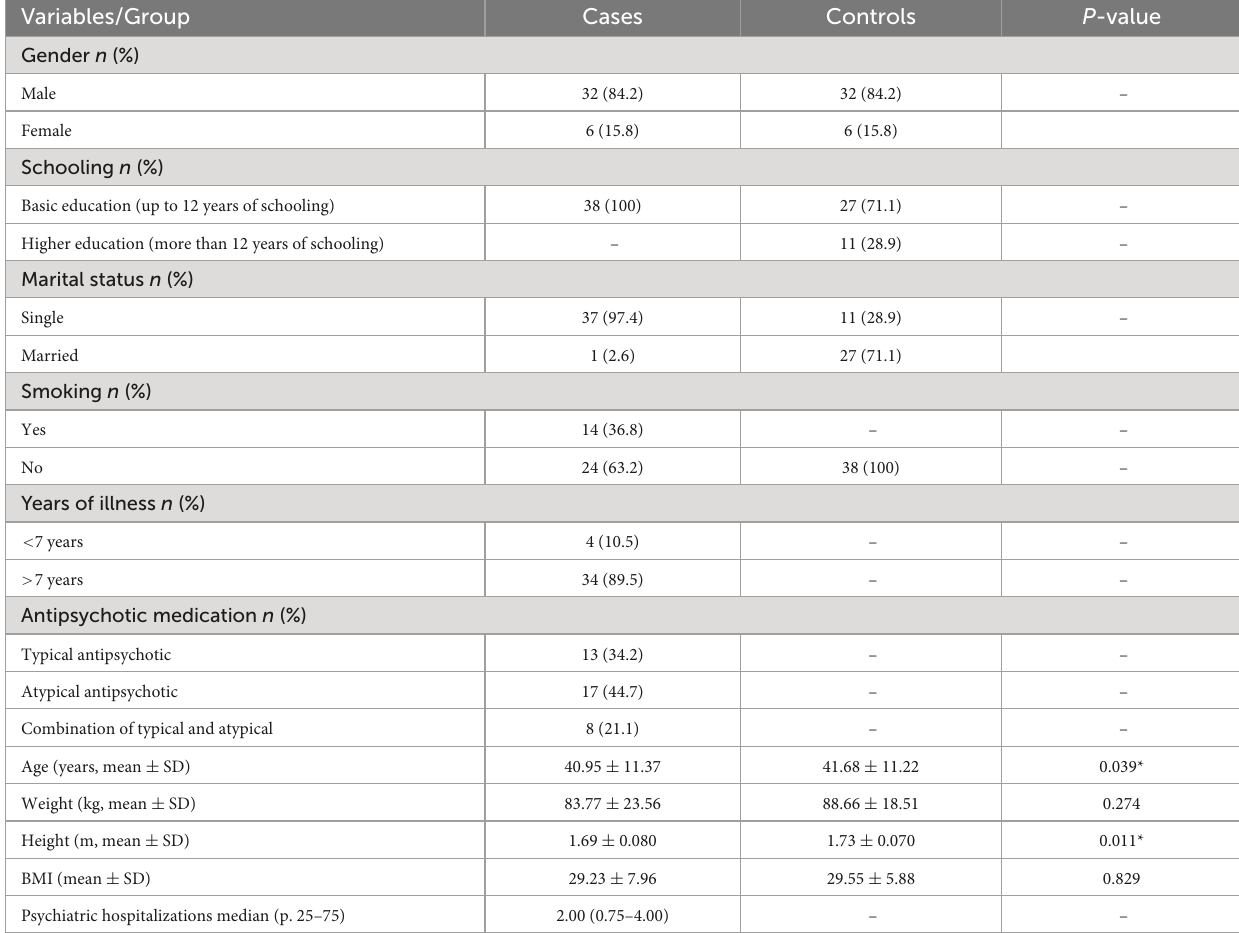
TABLE 1 Baseline sample